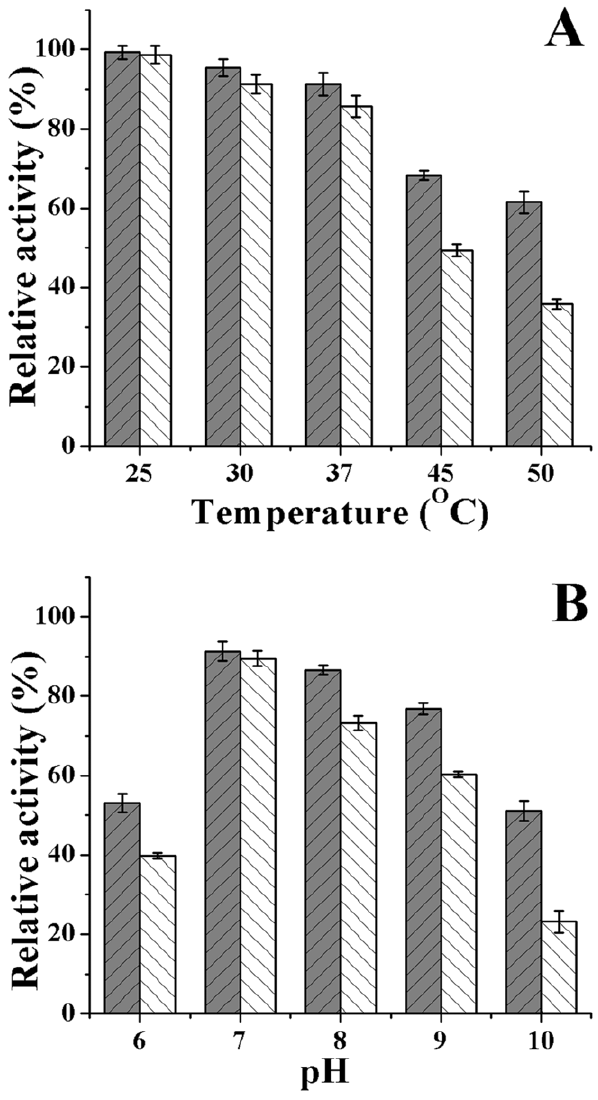
Figure 6. The effects of pH and temperature on the activity of free (white bar) and immobilized enzyme (grey bar). The effect of temperature on free and immobilized enzyme (A). The samples were pre-incubated in PBS at temperature ranging from 25 to 50 u C for 3 hours. The effect of pH on free and immobilized enzyme (B). The samples were pre-incubated at 4 u C in buffer at pH ranging from 6 to 10 for 24 hours.